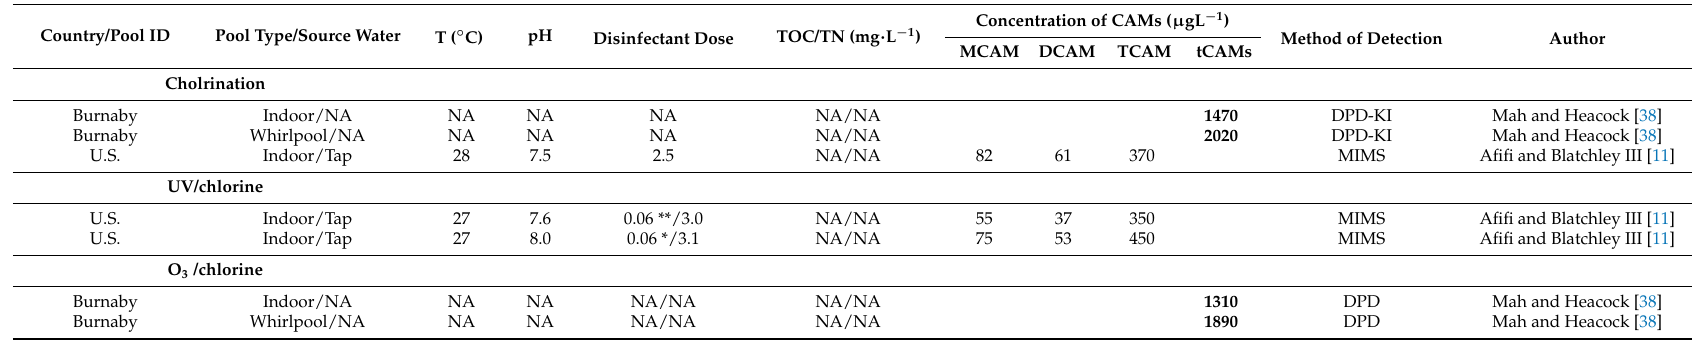
Table A7. Concentration of CAMs with different methods of